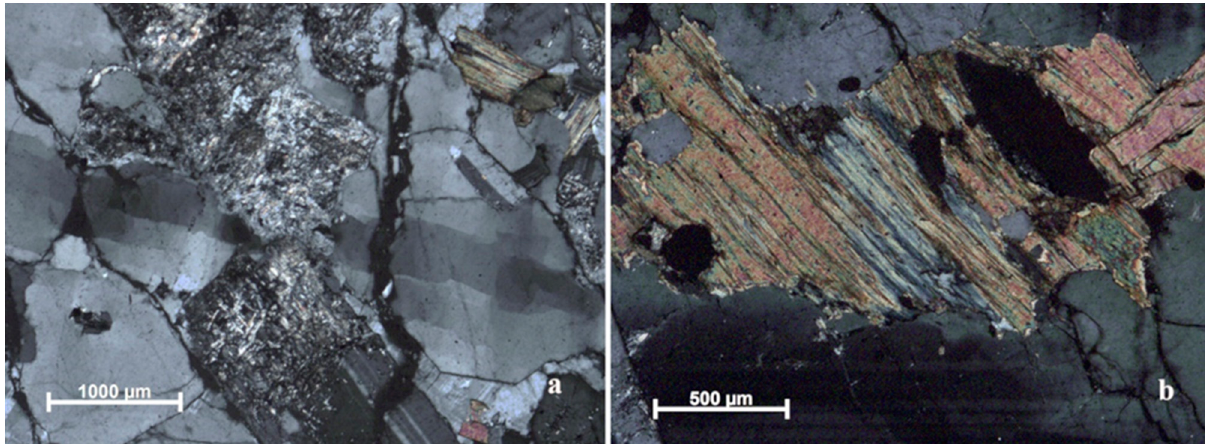
Figure 7. Image in petrographic thin section (crossed polarisers): in the centre of the image there is a plagioclase affected by sericitisation phenomena (sericite with higher interference colours (yellowish) (a); image in petrographic thin section (crossed polarisers). In the centre of the image, there is a biotite with partial transformation in chlorite (b).